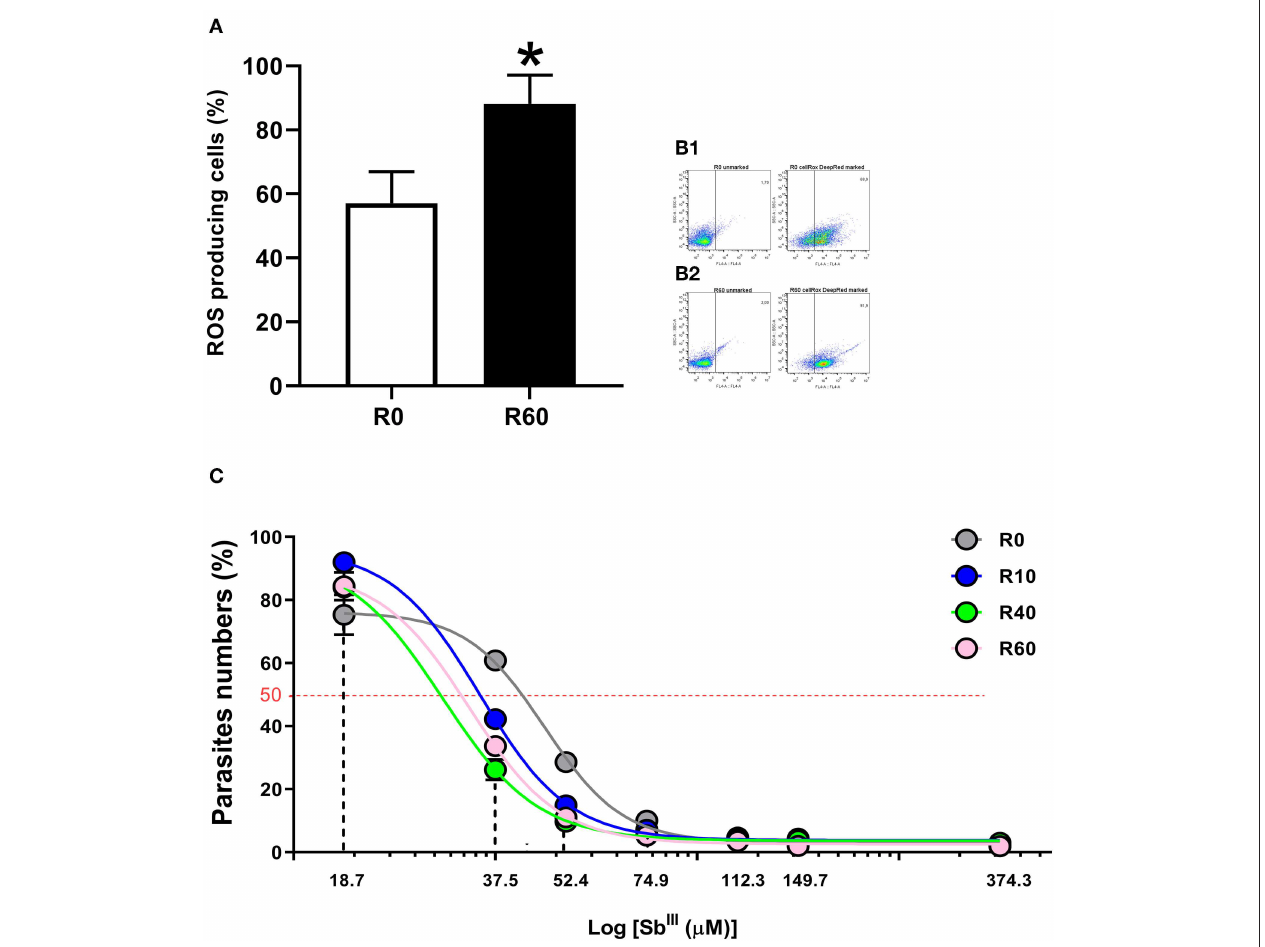
FIGURE 8 | Reactive oxygen species (ROS) measurement in L. amazonensis promastigotes after SIVP. R0 and R60 promastigotes were cultivated in M199 medium (10% BFS, 26 ◦ C). The level of ROS was assessed by CellROX Deep Red Reagent (Thermo Fisher Scientific). After treatment, R0 and R60 cultures at late log